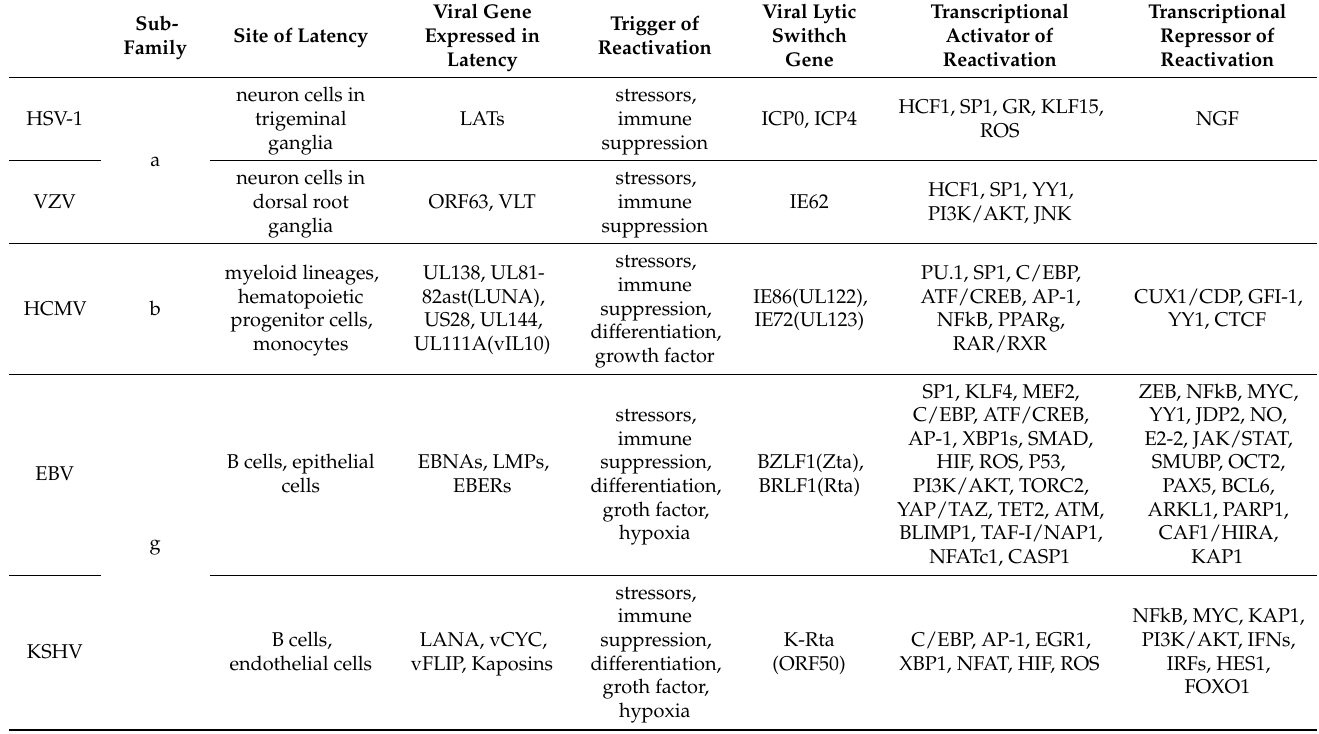
Table 1. Latency and lytic reactivation of human herpesviruses.